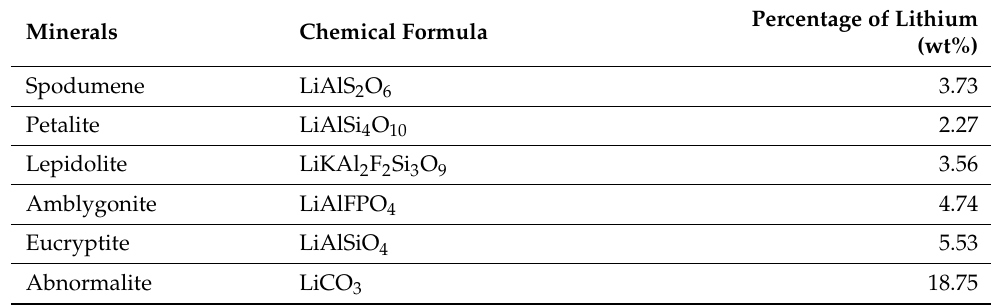
Table 1. Chemical composition with the percentage of lithium in minerals [16,17].